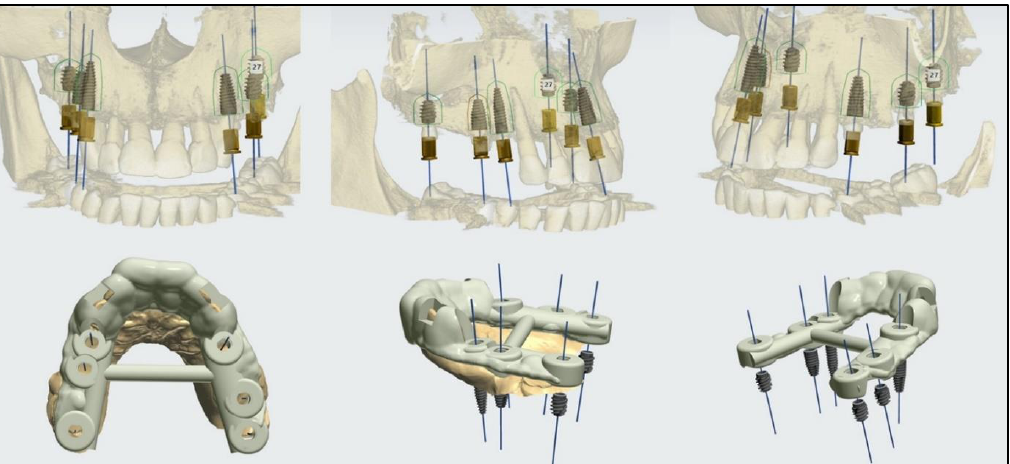
Figure 15. Digital planning of the surgical guide for Case 2.